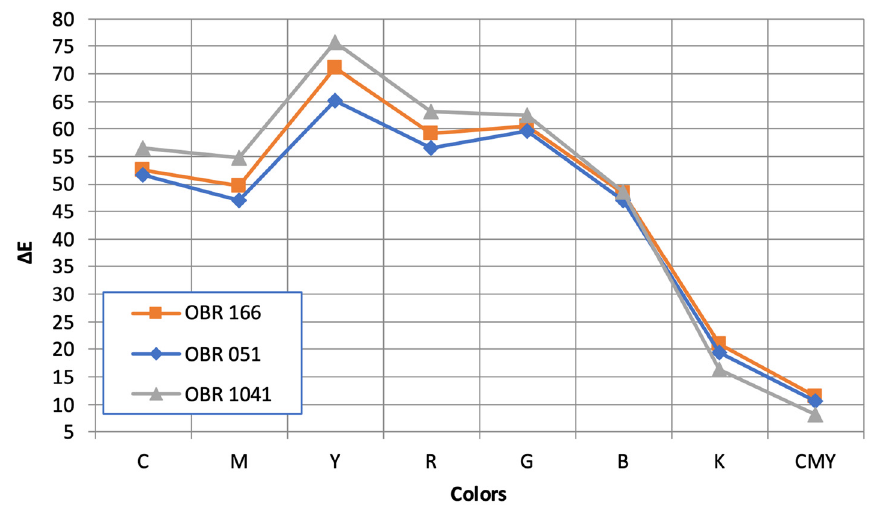
Figure 13. Different colors changes of Δ E on natural linen fabrics when printing in 4 passes with 2